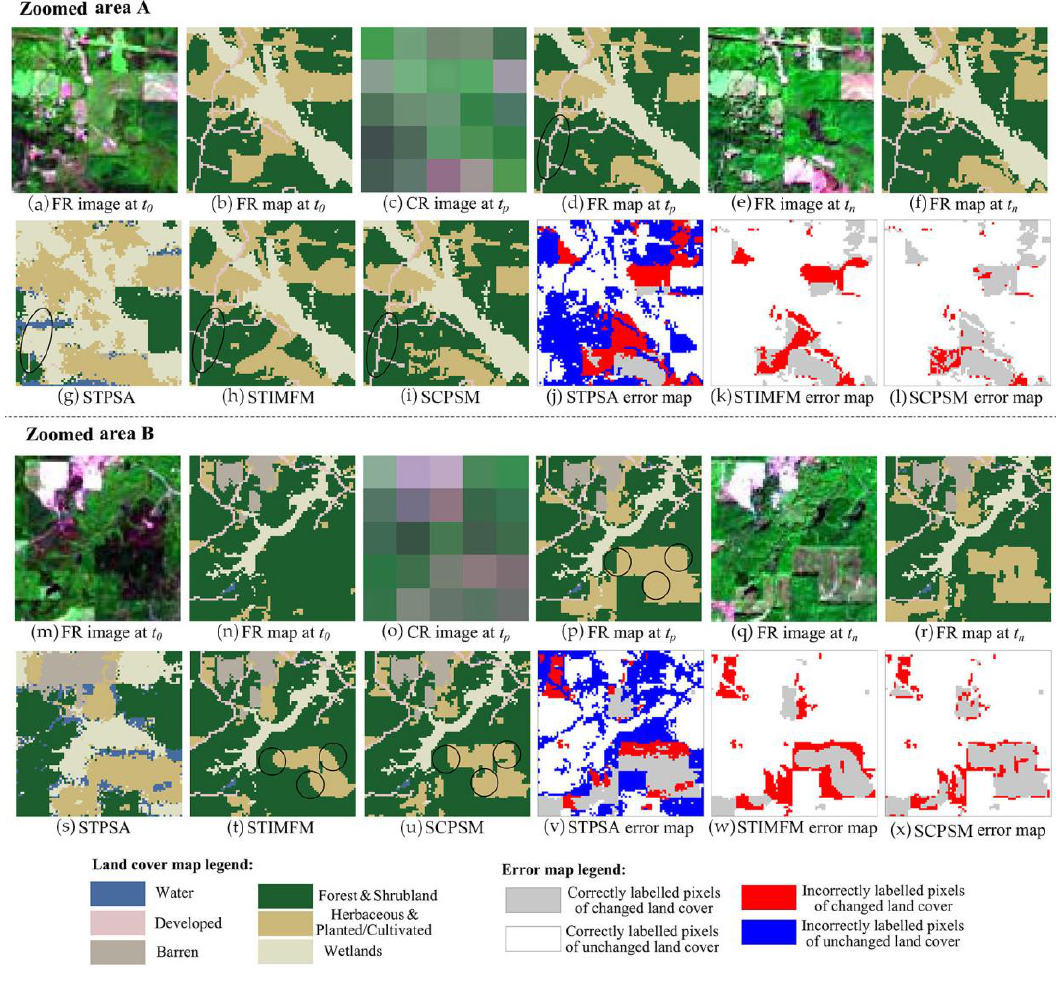
Figure 7. Input, reference, resulting land cover maps and error maps for the zoomed areas in Figure 6 in the NLCD experiment. Each zoomed area contains 80 × 80 FR pixels. ( a – l ) are the input, reference, resulting maps and error maps for zoomed area A: ( a ) FR image at t 0 ; ( b ) FR map at t 0 ; ( c ) CR image at t p ; ( d ) FR map at t p ; ( e ) FR image at t n ; ( f ) FR map at t n ; ( g ) STPSA; ( h ) STIMFM; ( i ) SCPSM; ( j ) STPSA error map; ( k ) STIMFM error map; ( l ) SCPSM error map. ( m – x ) are the input, reference, resulting maps and error maps for zoomed area B: ( m ) FR image at t 0 ; ( n ) FR map at t 0 ; ( o ) CR image at t p ; ( p ) FR map at t p ; ( q ) FR image at t n ; ( r ) FR map at t n ; ( s ) STPSA; ( t ) STIMFM; ( u ) SCPSM; ( v ) STPSA error map; ( w ) STIMFM error map; ( x ) SCPSM error map.